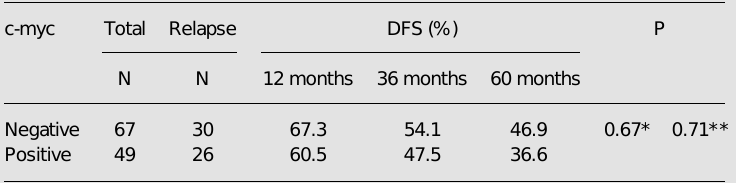
Table 2. Disease-free survival (DFS) of cervical carcinoma patients stratified by FIGO stage and c-myc